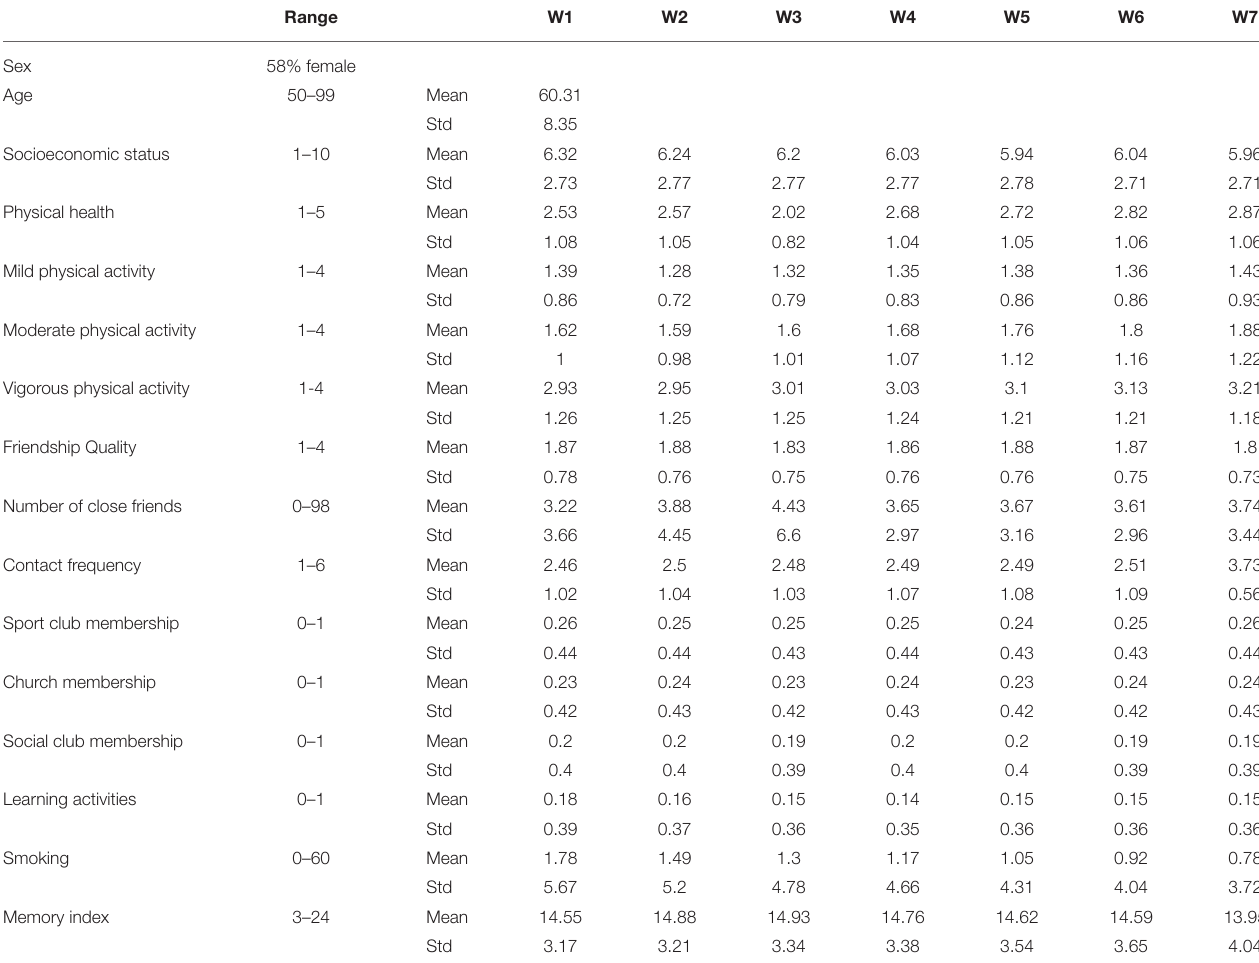
TABLE 1 | Descriptive statistics for demographics, candidate treatment variables, and the cognitive function measure used in the analysis.